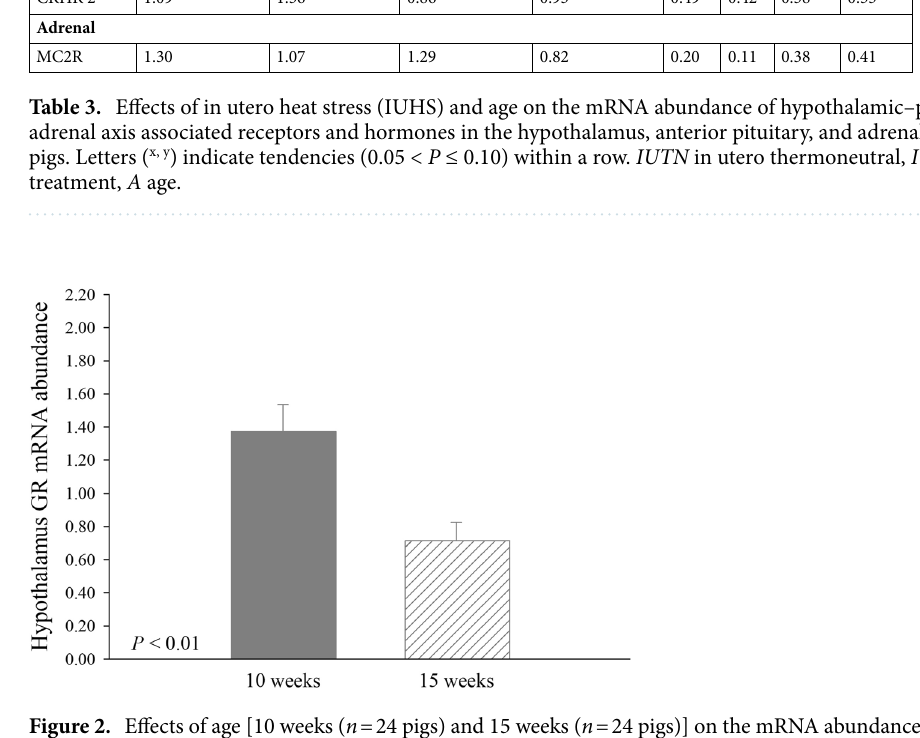
Figure 2. Effects of age [10 weeks ( n = 24 pigs) and 15 weeks ( n = 24 pigs)] on the mRNA abundance of glucocorticoid receptor (GR) in the hypothalamus of pigs. Data are presented as LSmeans ±